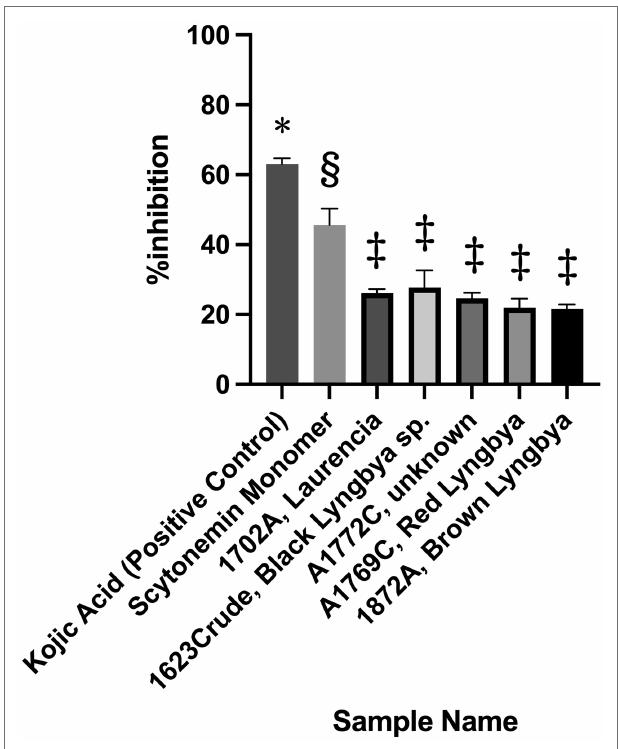
FIGURE 3 | Tyrosinase inhibitory activity of the best candidates from the broad screening of extracts, fractions and pure compounds at 10 μ g/ml. Error bars represent standard deviation. Symbols (*, §, ‡) indicate significant difference (at 0.05 level) by the Tukey–Kramer multiple comparison test. * vs. other groups, p < 0.001; § vs. other groups, p < 0.001. No significant difference is noted between groups labeled with same